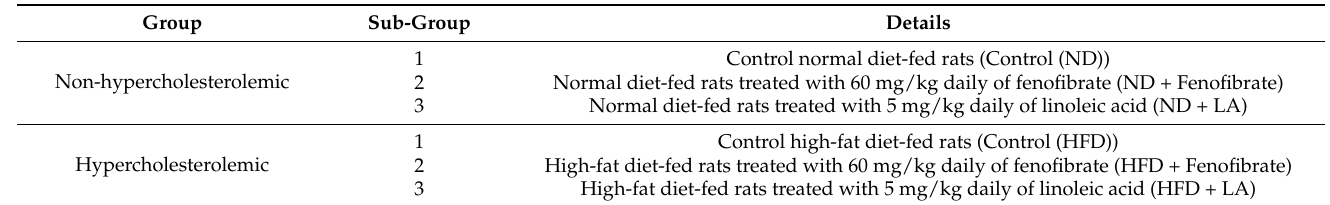
Table 1. Grouping of the experimental animals based on diet and treatment. Group Sub-Group Details